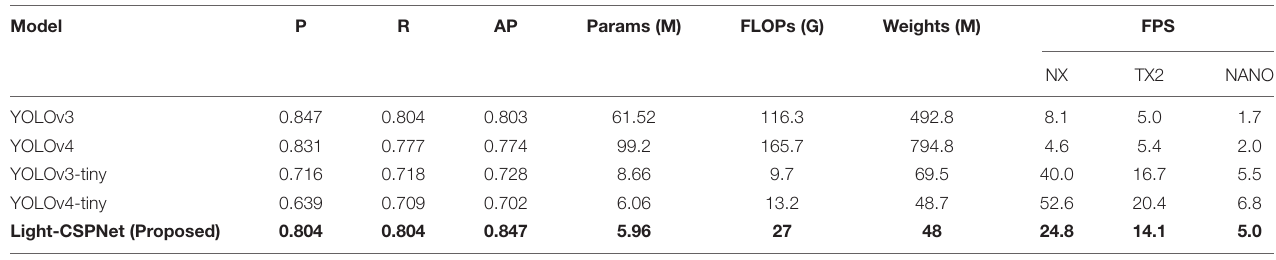
TABLE 3 | Test results for the tomato dataset.